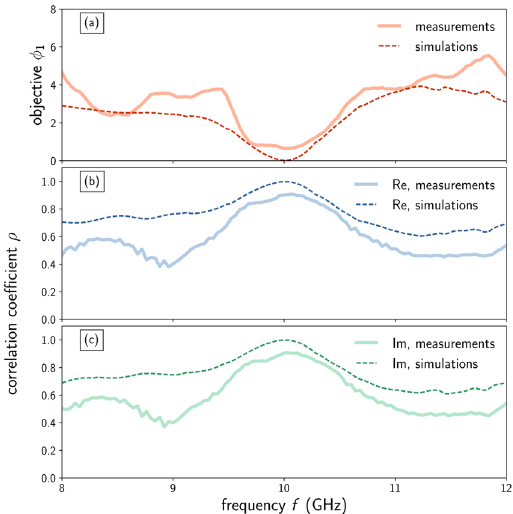
Figure 4. Performances of the illusion device. Measured (thick solid lines) and computed (thin dashed lines) figures of merit as a function of frequency f : partial objective function φ 1 representing the relative error between the reference and illusion electric fields ( a ), and correlation coefficient between those fields for the real ( b ) and imaginary ( c )